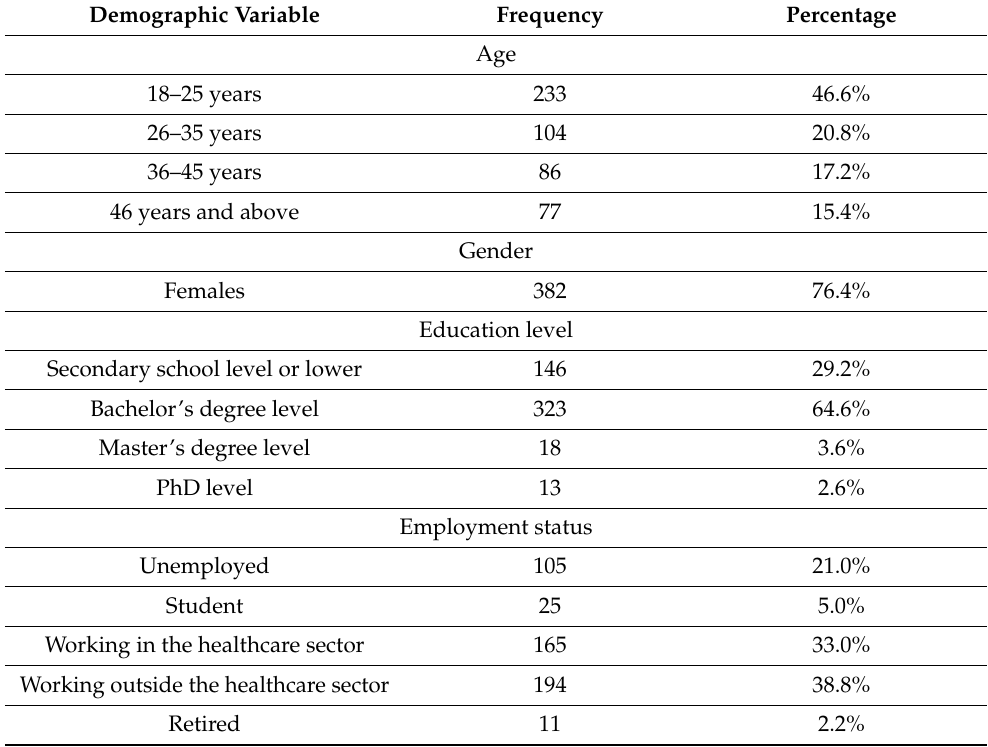
Table 1. Participants demographic characteristics.